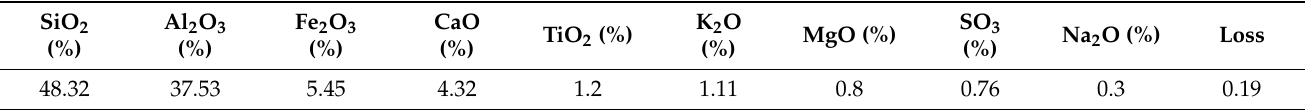
Table 4. The chemical composition of fly ash.